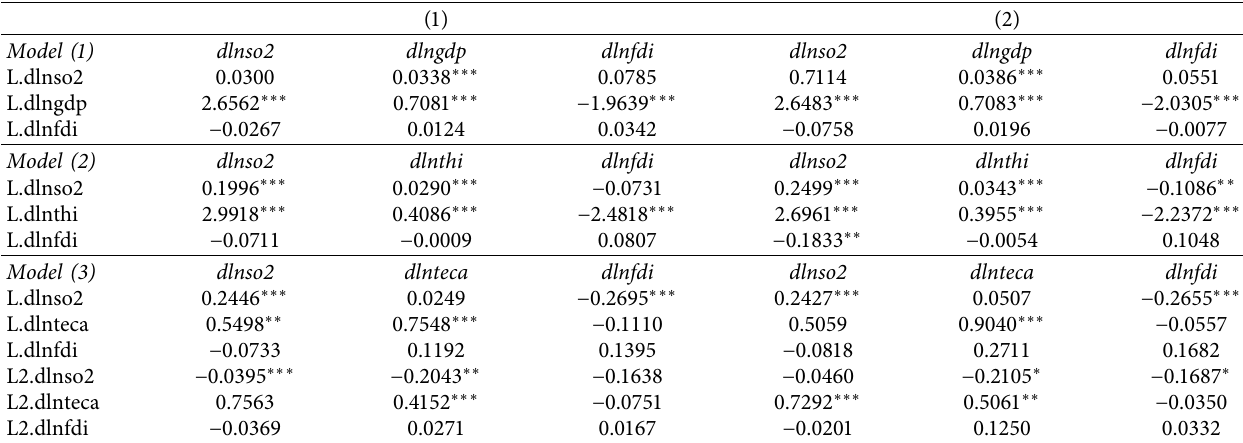
Table 9: Estimation results of the robustness test.